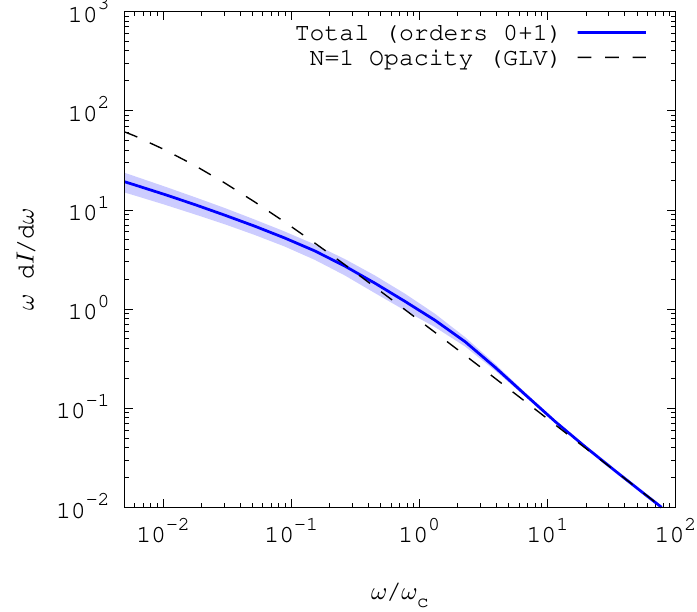
Figure 5 . The medium-induced spectrum to NLO in the expansion around the harmonic oscillator (BDMPS) (blue solid line). The blue band represents the variation of the IR transverse scale between (cid:22) 2 = 2 and 2 (cid:22) 2 , (cid:22) = 0 : 3 GeV being the central value. The GLV spectrum (dashed) is also plotted for